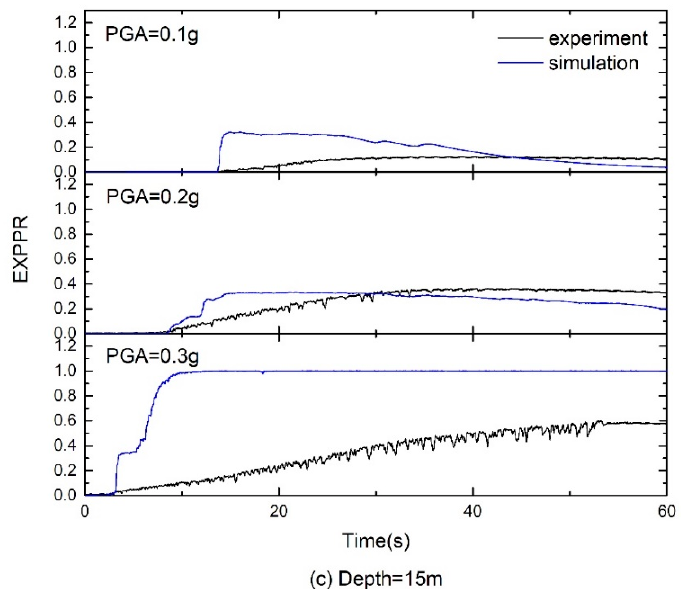
Figure 10. Time histories of EXPPR at different observation points: ( a ) depth = 5 m; ( b ) depth = 10 m; ( c ) depth = 15 m.